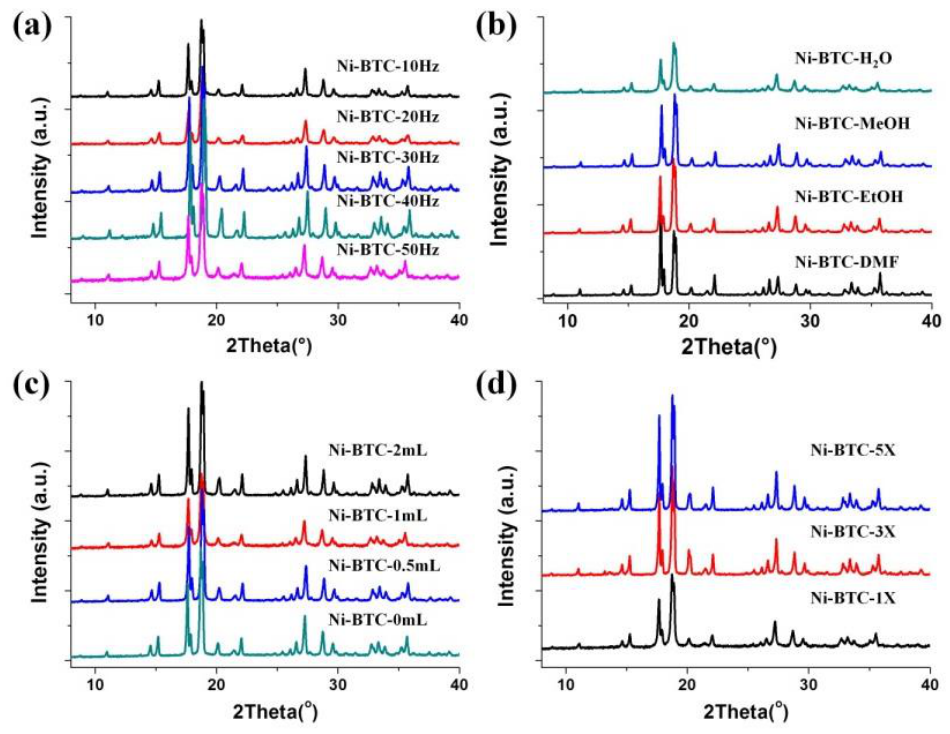
Figure 4. XRD patterns of the Ni-BTC samples obtained at various grinding frequencies ( a ), with addition of different solvents ( b ), with addition of varied amount of water ( c ), and at enlarged scales ( d ).